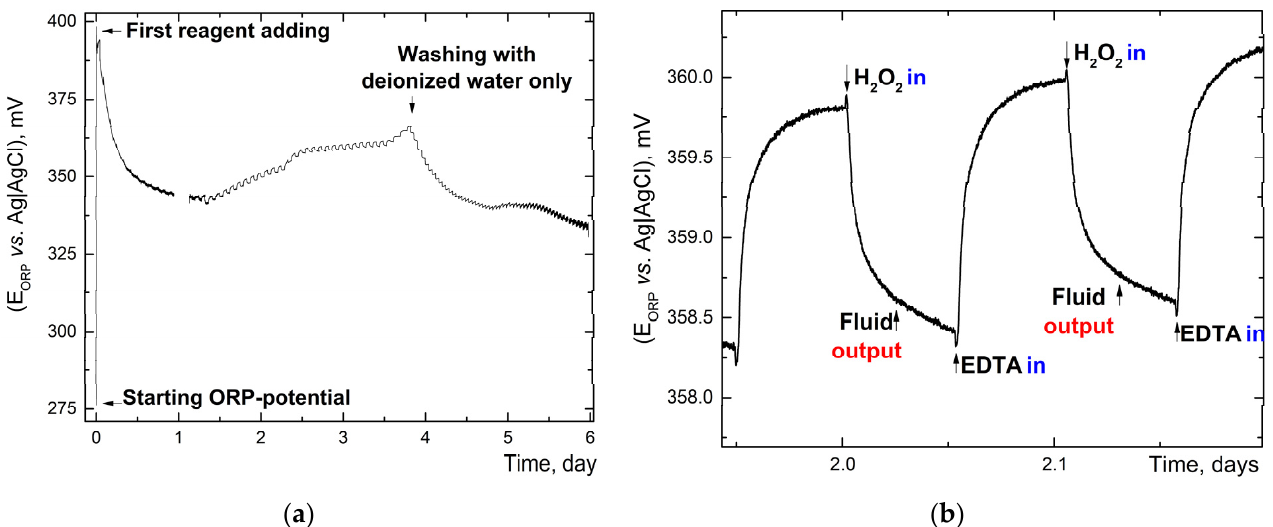
Figure 3. The profile of ORP potentials during the dialysis process. ( a ) Overall process. ( b ) Increased scale of ORP potential when filling the purification reagents (H 2 O 2 and EDTA). EDTA increases ionic strength of the solution and changes ORP. Signal logging every 1 s for 6 days.